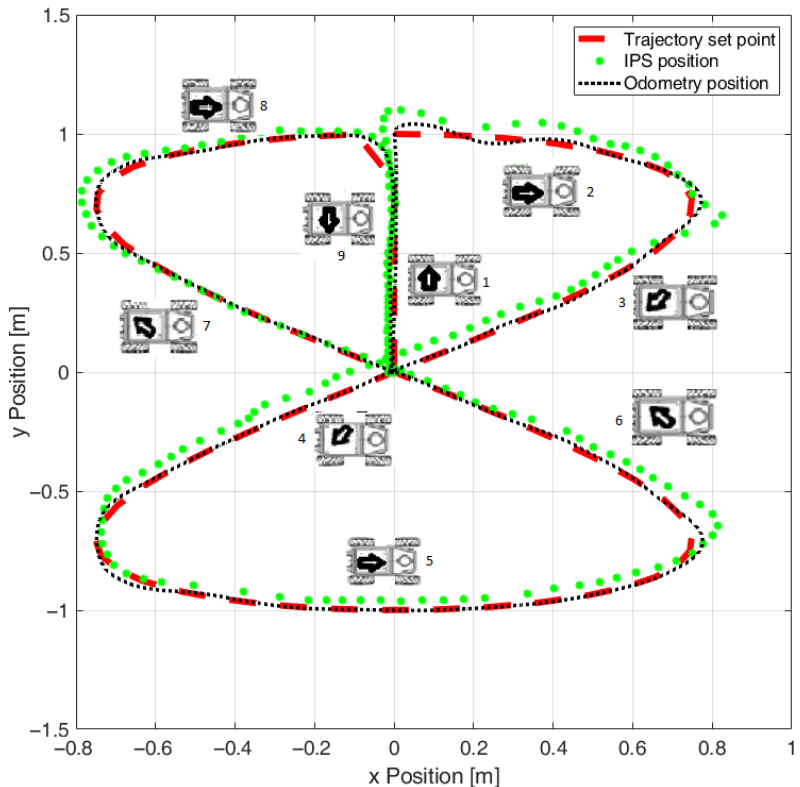
Figure 6. Initial experiments with odometry calibration (the numbered icons indicate the direction and the order of travel on the trajectory